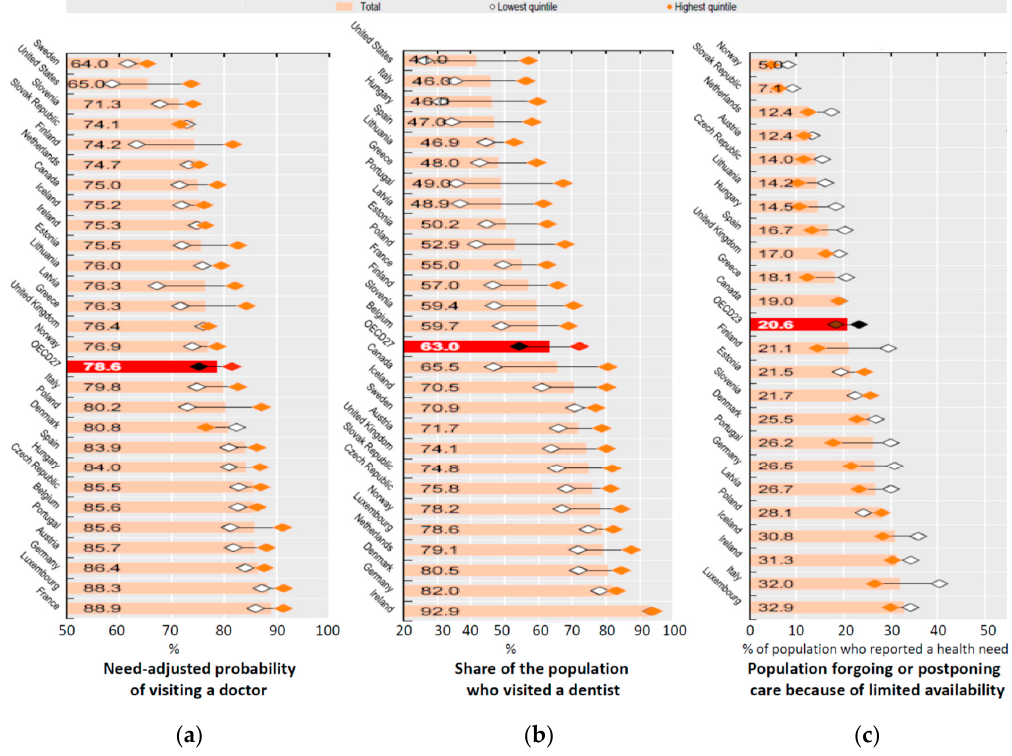
Figure 29. The statistics in 2014 for visits to ( a ) doctors and ( b ) dentists, and ( c ) the population forgoing or postponing care because of limited availability.